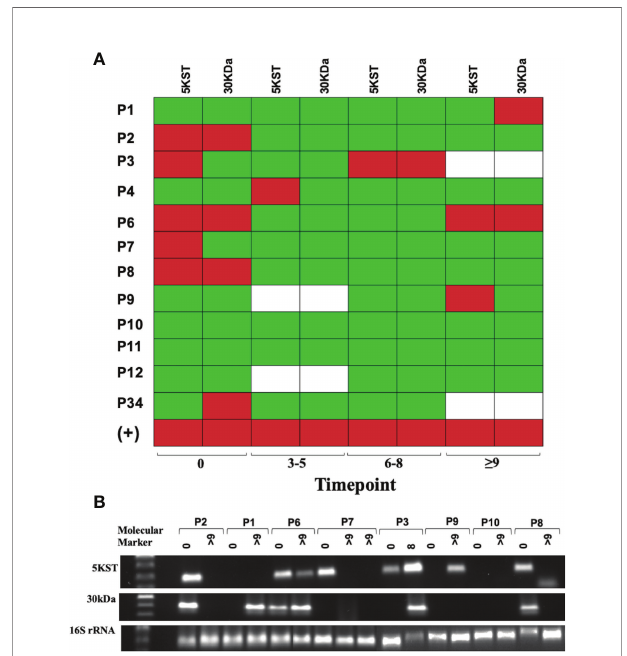
FIGURE 6 | Mycobacterial 5KST and 30kDa antigens are in exosomes from DR-TB patients. Representative results from ampli fi cation fragments are presented as a heat map for (A) 5KST and 30kDa (n =12). Red square = positive ampli fi cation; green square = negative ampli fi cation, and white square = non-determined. (B) Electrophoresis of 5KST, 30kDa and 16S rRNA ampli fi cation